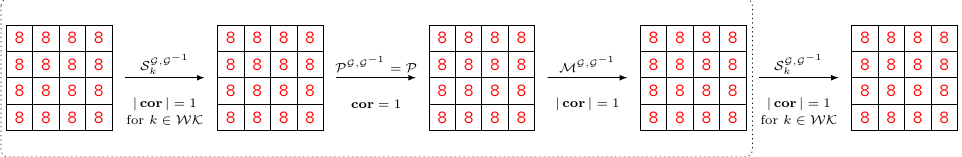
Figure 1: The G -shifted linear trail for one round of Midori64 corresponding to the invariant attack. G = ( G, G, . . . , G ) is any permutation for which h 8 , G ( x ) i is equal to the invariant g ( x ) = x 3 x 2 + x 2 + x 1 + x 0 for the S-box. In this trail, all S-boxes are